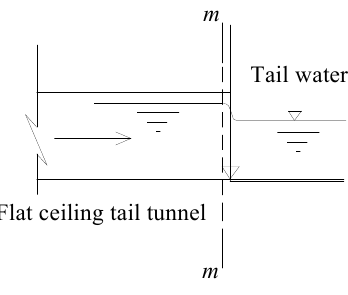
Figure 4. Outlet of the tail tunnel.